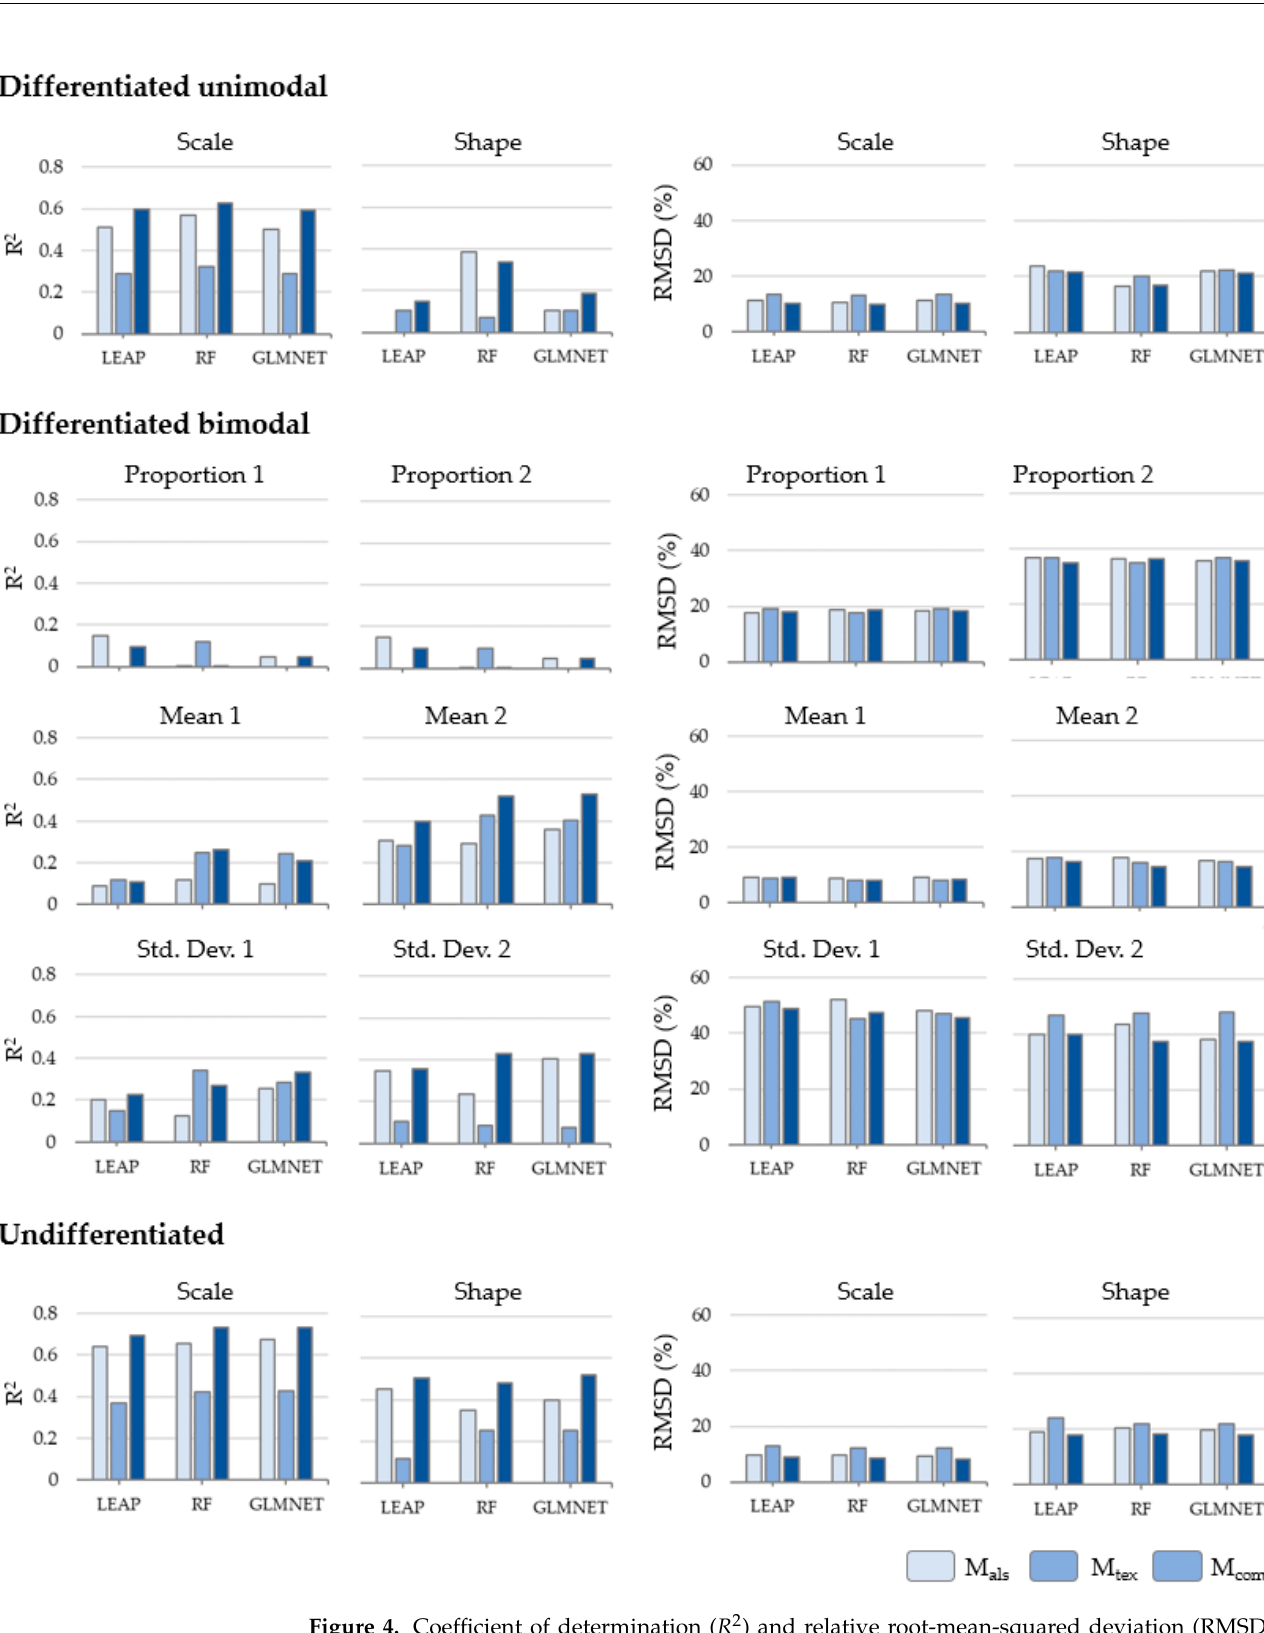
Figure 4. Coefficient of determination ( R 2 ) and relative root-mean-squared deviation (RMSD%) that was derived from the application of the SDD prediction models to the test case data using the differentiated unimodal, differentiated bimodal, and undifferentiated SDD modality plot groupings; three ALS metrics sets (M als , M tex , and M comb ) and three modelling techniques (RF, GLMNET, LEAP) were used.